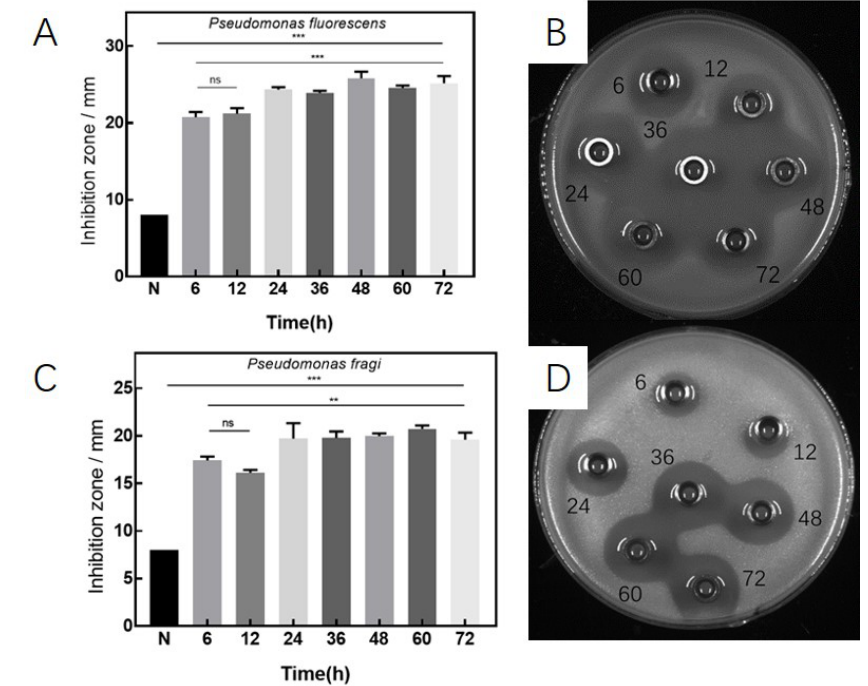
Figure 5. Antibacterial effects of D. algida under different culture times against the target Pseudomonas , where ( A , B ) and ( C , D ) are P. fluorescens and P. fragi , respectively. The numbers in ( B , D ) stand for the culture time. The data are shown as mean ± SD ( n = 3), ** p < 0.01, *** p < 0.001. Under the various salinities, as depicted in Figure 6, the generation of the antibacterial substance is in different cases. Compared with the blank control group, the cultured D. algida using mediums with salinities of 0–10% ( w / v ) shows inhibition effects, which decrease as the salinity increases. The growth of D. algida is inhibited by the salinity, instead of suppressing the effects of the antibacterial substance by the great salinity.